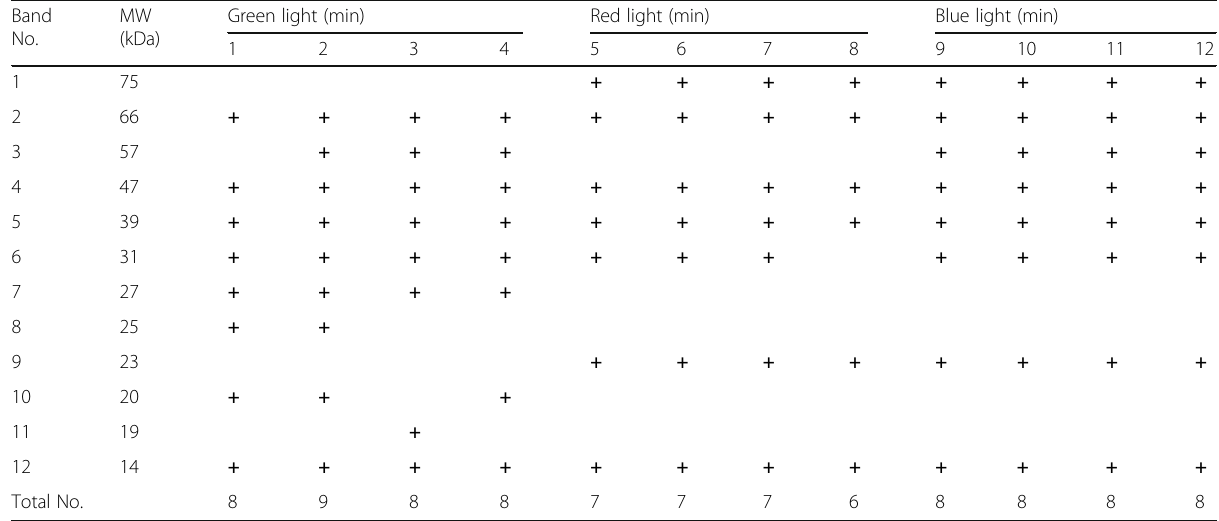
Table 5 SDS-PAGE profile of total proteins extracted from Eustoma grandiflorum plants as respond to different leaser light irradiation Band